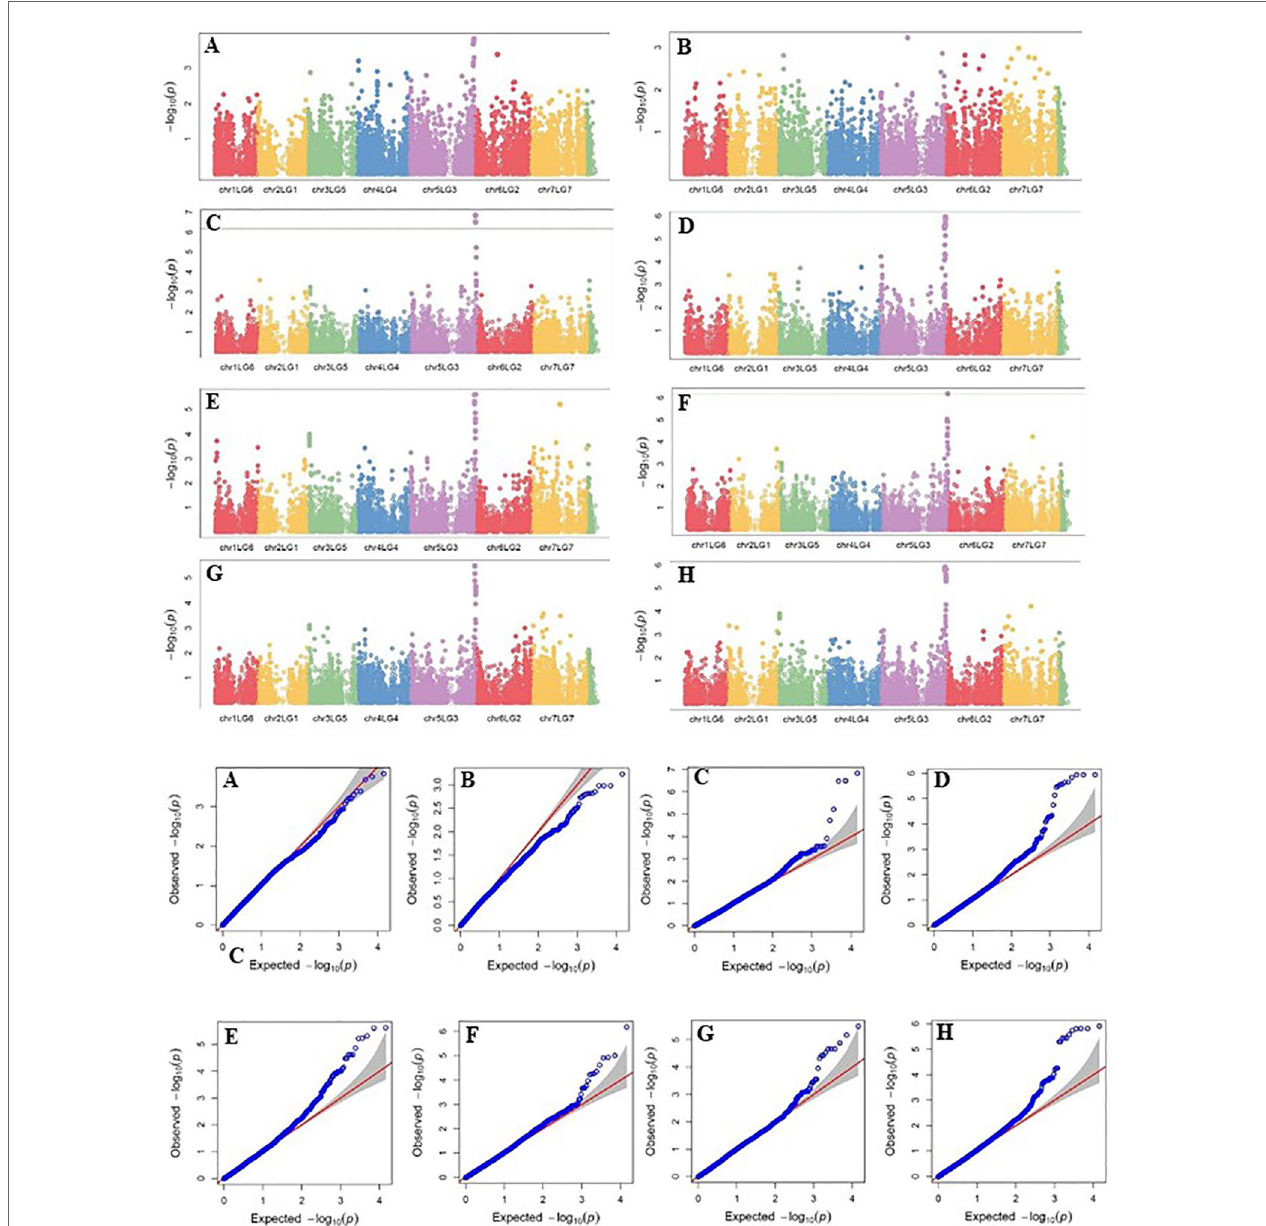
FiGUre 5 | Manhattan plots and the corresponding Q-Q plots representing the identification of SNP markers associated with plant height in multiple trials. (A) 2013 Fargo (B) 2013 Sutherland, (c) 2014 Sutherland, (D) 2015 Sutherland, (e) 2016 Rosthern, (F) 2016 Sutherland, (G) 2017 Rosthern, and (h) 2017 Sutherland. The Manhattan plots are based on association of 15608 chromosomal and1269 non-chromosomal SNPs with plant height of 135 pea accessions in the multi-year, multi-locational